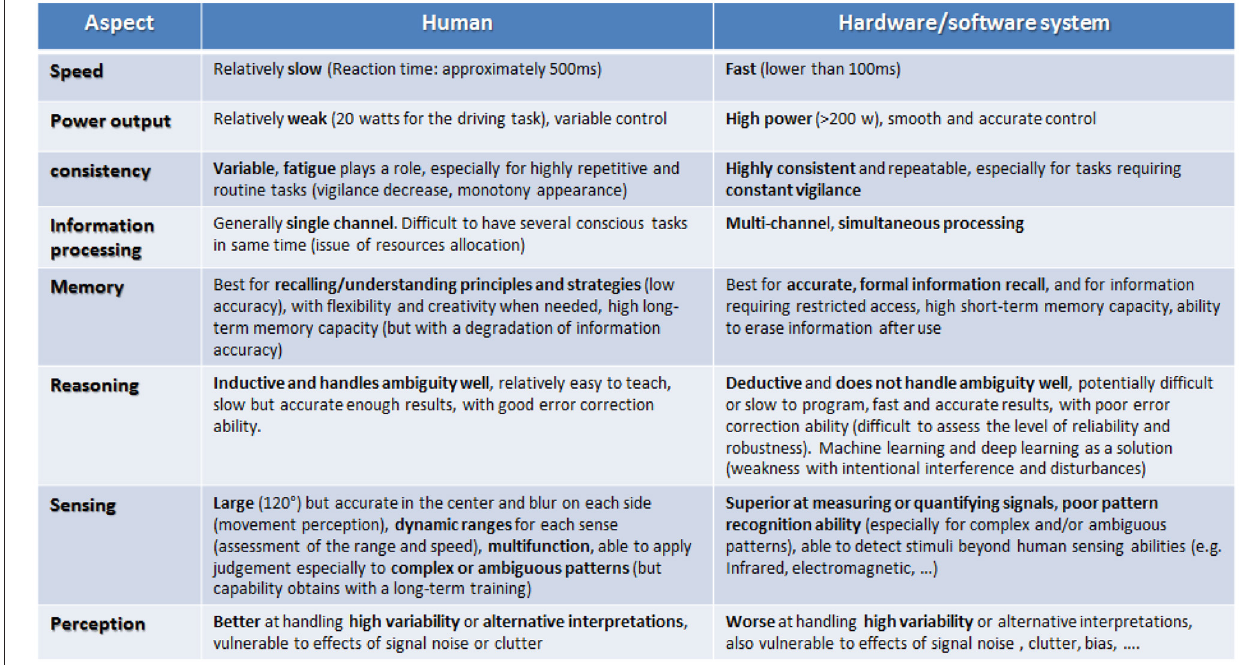
Frontiers in Sustainable Cities |